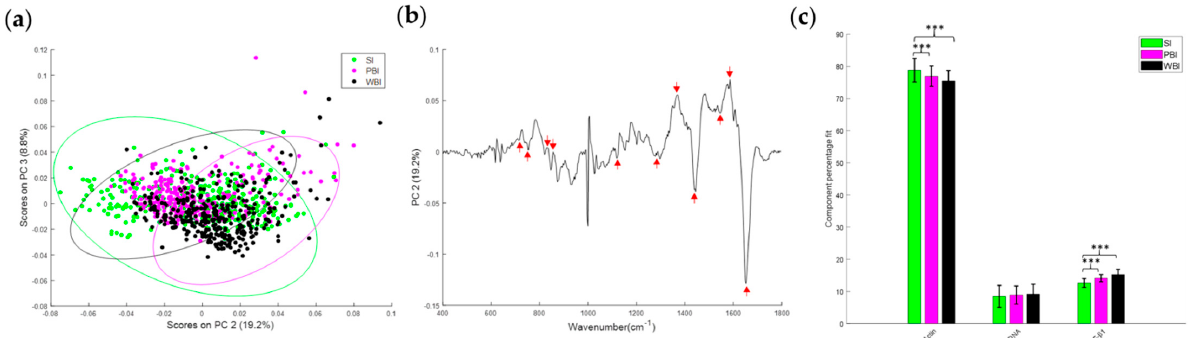
Figure 6. ( a ) PCA scatterplot of Raman spectral data from SI (green), PBI (magenta) and WBI (black) mice 6 months post-irradiation. ( b ) PC loading from PCA of Raman spectral data from SI, PBI and WBI mice 6 months post-irradiation showing the spectral features responsible for the separation among the groups (red arrows). ( c ) Relative weightings of actin, DNA and TGF- β from least squares fitting of Raman spectra from SI, PBI and WBI groups 6 months post-irradiation. Error bars represent the standard error. *** p ≤ 0.001.